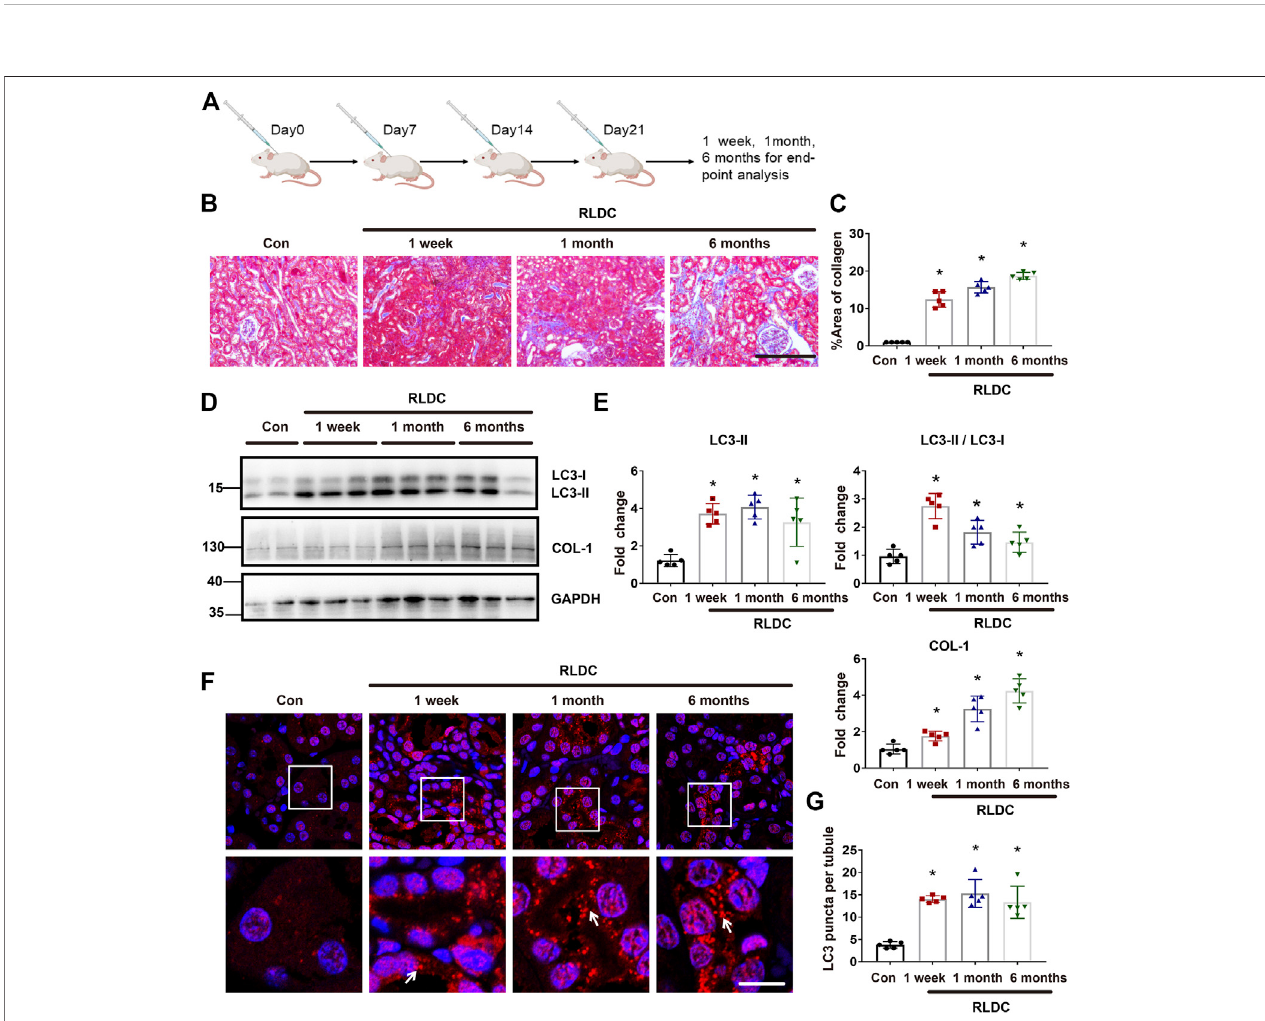
FIGURE 1 | Persistent autophagy activation in kidneys after RLDC treatment in mice. Male C57BL/6 mice were injected weekly with 8 mg/kg cisplatin for 4 weeks (RLDC) or with saline as control (Con) to collect samples at 1 week, 1 month and 6 months later. (A) The schematic representation of the RLDC model regimen. (B) Masson staining of kidney tissues. ( n = 5, bar = 50 μ m). (C) Statistical analysis of the area of collagen deposition in Masson staining. (D) Representative immunoblots of LC3, COL-1 and GAPDH (loading control) in kidney tissues ( n = 5). (E) Densitometry of LC3II, LC3II/LC3I and COL-1. The experimentswere normalized according to GAPDH expression. The protein level of control group (Con) was arbitrarily set as 1, and the signals of other conditions were normalized with the control group to indicate their protein fold changes. (F) Representative images of immuno fl uorescence staining of LC3B. ( n = 5). (G) Statistical analysis of the number of LC3B spots per renal tubule. All quantitative data are expressed as mean ± SEM. * p < 0.05 vs the control group (Con).